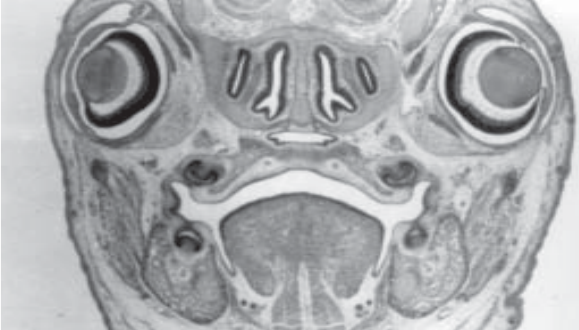
6 – Treated Group - Frontal slice of the head of embryos. H&E. Magnification: 32X